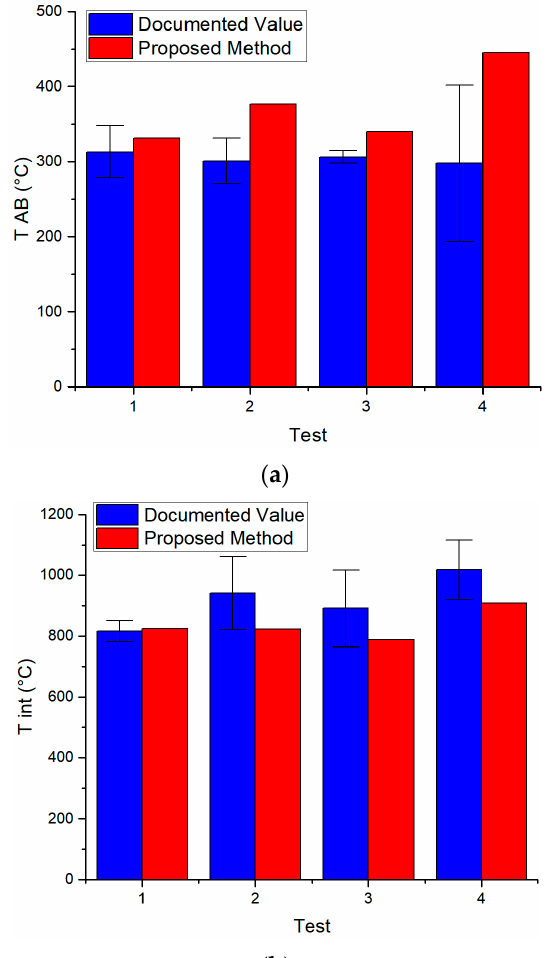
Note: R denotes a reference value [41,42].